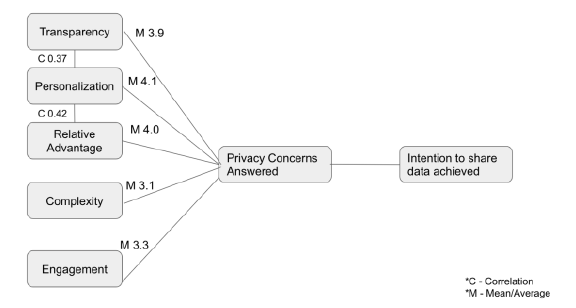
Figure 2 . Results For Structural Model Of Privacy